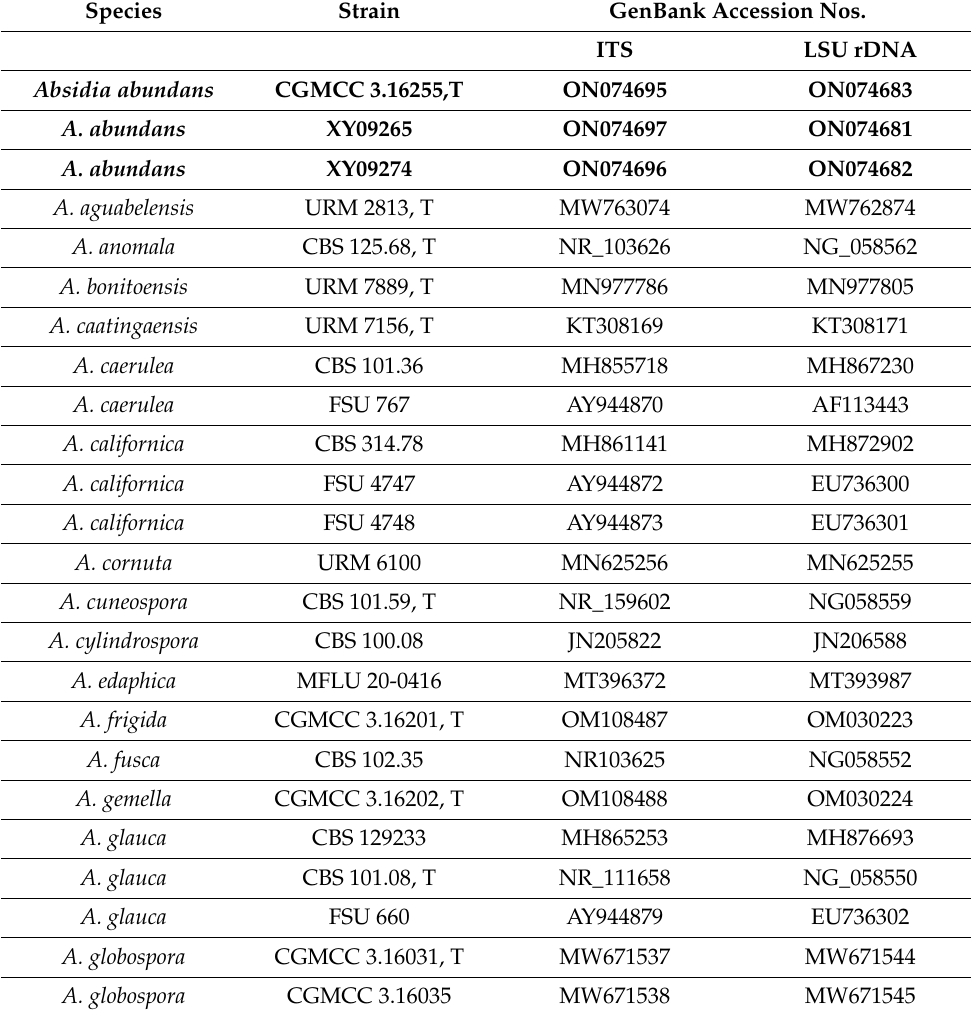
Table 2. Taxa information and GenBank accession numbers used in this study. Species Strain GenBank Accession